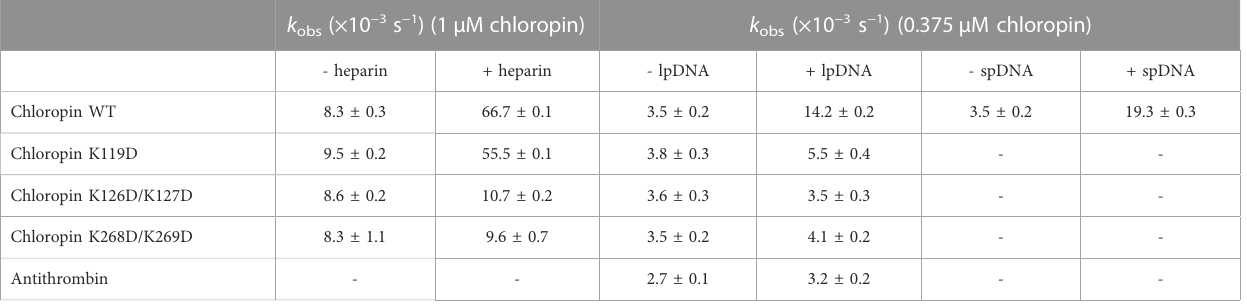
TABLE 2 Effect of heparin and DNA on the thrombin inhibition by chloropin variants. Chloropin variants (1 μ M), thrombin (0.1 μ M) and heparin (0.1 μ M) were mixed at 20 ° C for different time intervals and the remaining protease activities were measured with the k obs values calculated. The DNA effect was similarly assessed with375 nMchloropin,75 nM thrombinand0.8 nM linear plasmid DNA (lpDNA). Chloropin canbe substituted byantithrombin, andlinear plasmid DNA can be substituted by Supercoiled plasmid DNA (spDNA).